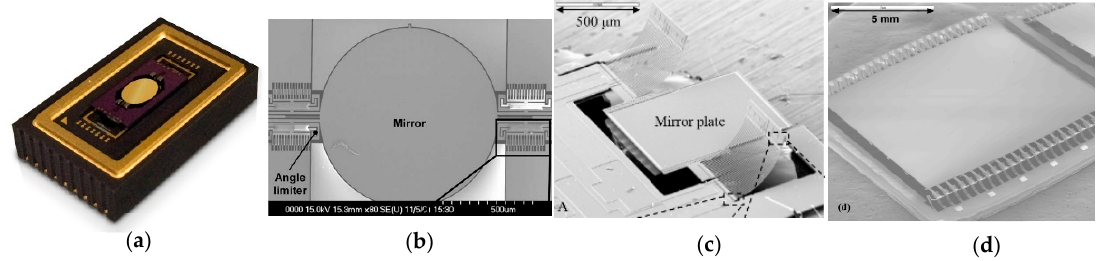
Figure 8. High FoM 1D non-resonant MEMS mirrors. ( a ) An electromagnetic actuator [67] (Image courtesy of Maradin, Yokneam, Israel); ( b ) An electrostatic MEMS mirror [68]; ( c ) An electrothermal MEMS mirror with a 180° non-resonant optical scanning angle [69]; ( d ) An electrothermal MEMS mirror with a mirror size of 10 × 10 mm 2 [70].